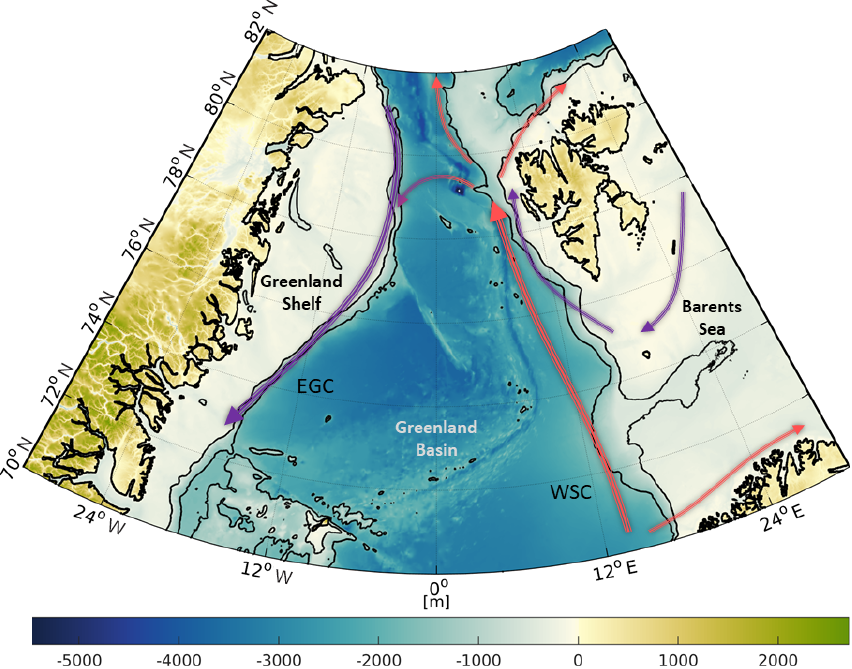
Figure 1. Bathymetry of the study area (northern Nordic Seas and Fram Strait) based on RTopo2 topography model (Schaffer et al., 2016). Major current systems (West Spitsbergen Current – WSC; East Greenland Current – EGC) are displayed by arrows in red (inflowing Atlantic water) and blue (returning polar water). Contour lines indicate depths of − 450 and −